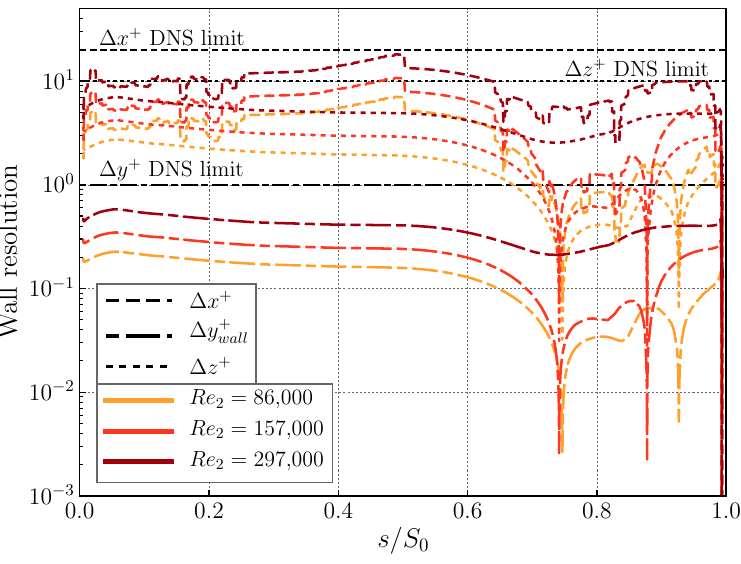
Figure 1. Wall resolution along the suction surface with increasing Re 2 and incoming